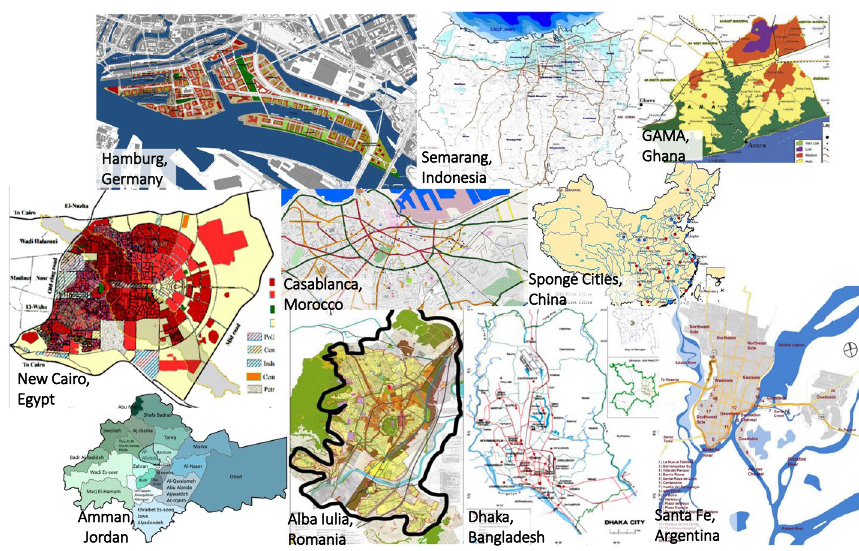
Fig. 8 Case-studies maps. Ref: literature